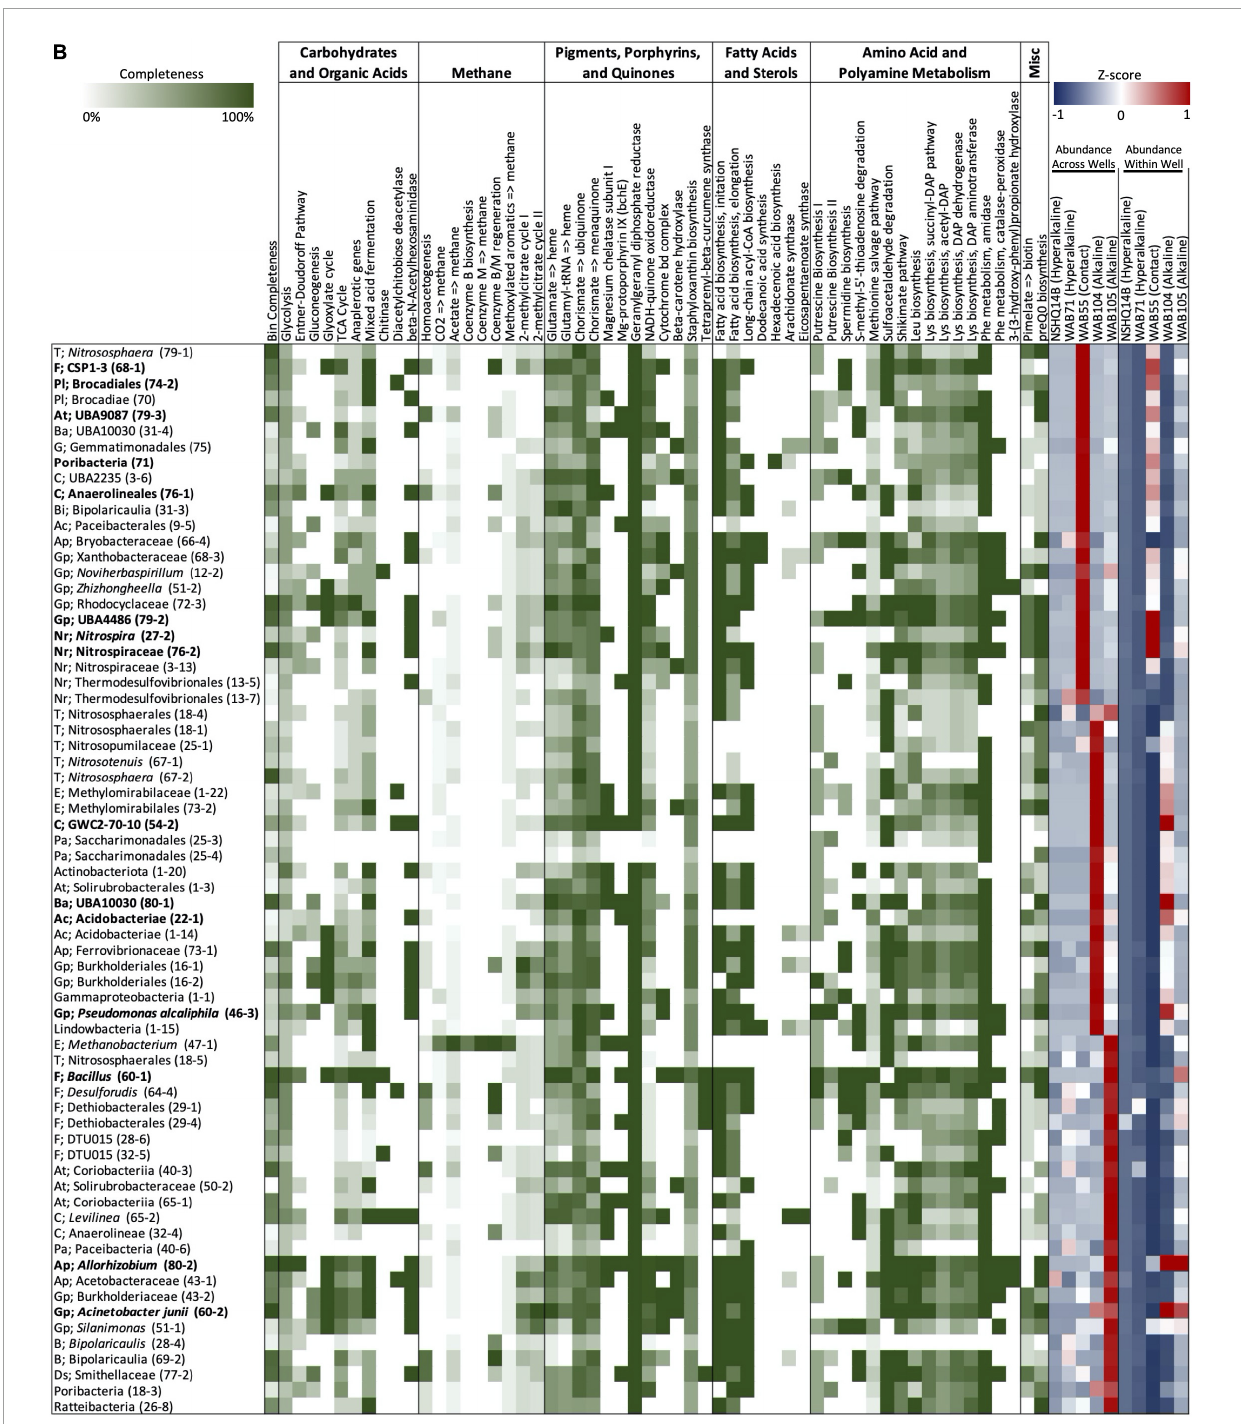
FIGURE6 (A,B) Metabolic genes and pathways of interest, annotated in each bin using KEGGDecoder and HMMER. Percentage completion of each pathway is indicated in shades of green. Z-scores of bin abundance within each well and across all wells are indicated in a blue/red heatmap at the top of the figure (negative z-scores in blue, positive z-scores in